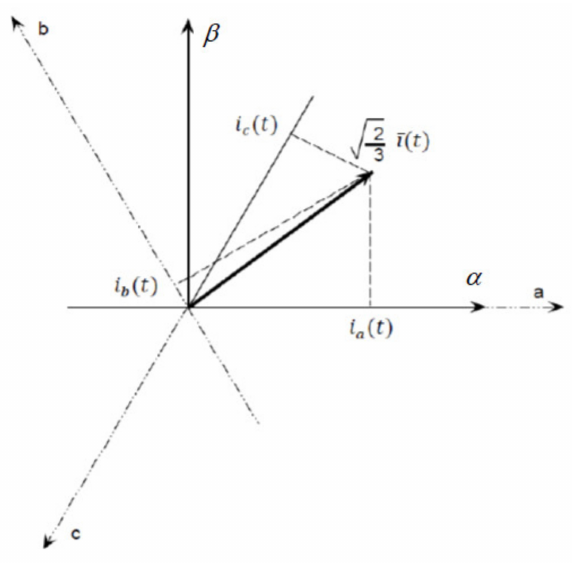
Figure 1. The phase variables a, b, c can be recovered as the instantaneous components of the space vector on the three axes a, b , and c whose angular displacement on the complex plane is 2 π